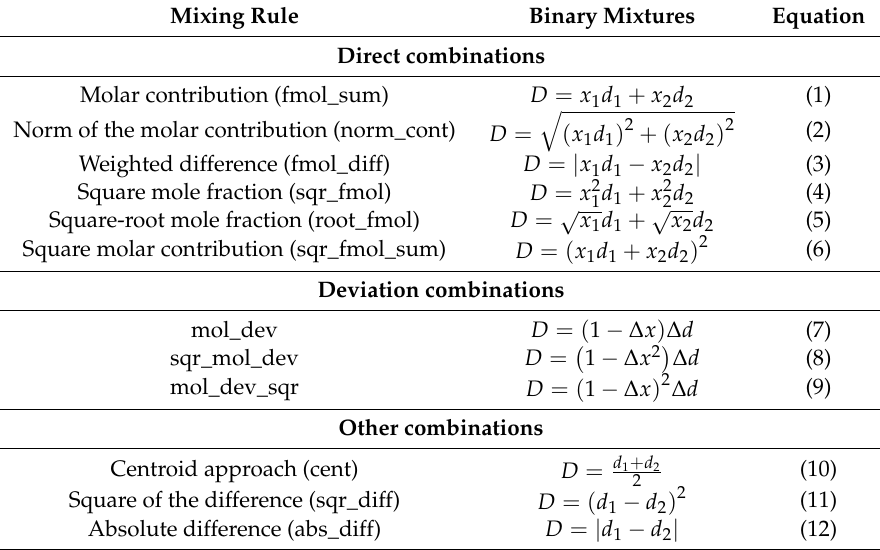
Table 2. Twelve formulas used for calculation of mixture